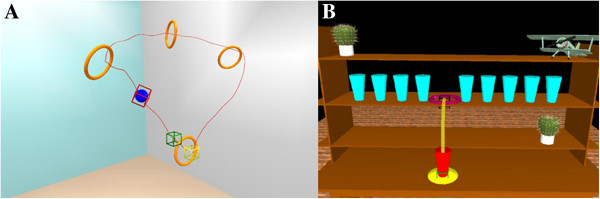
Motor exercises in the virtual environment. The two scenarios (VRRS® Khymeia Group, Ltd. Noventa Padovana. Italy) represent: A) a simple reaching movement: the patient has to raise the red glass and place it among the blue glasses on the shelf, according to a pre-recorded path (yellow line); B) a complex movement of increasing difficulty: the patient has to move the blue ball through the orange circles. The green box represents the start zone, while the yellow box represents the end zone to reach, following the circular-like displayed path.